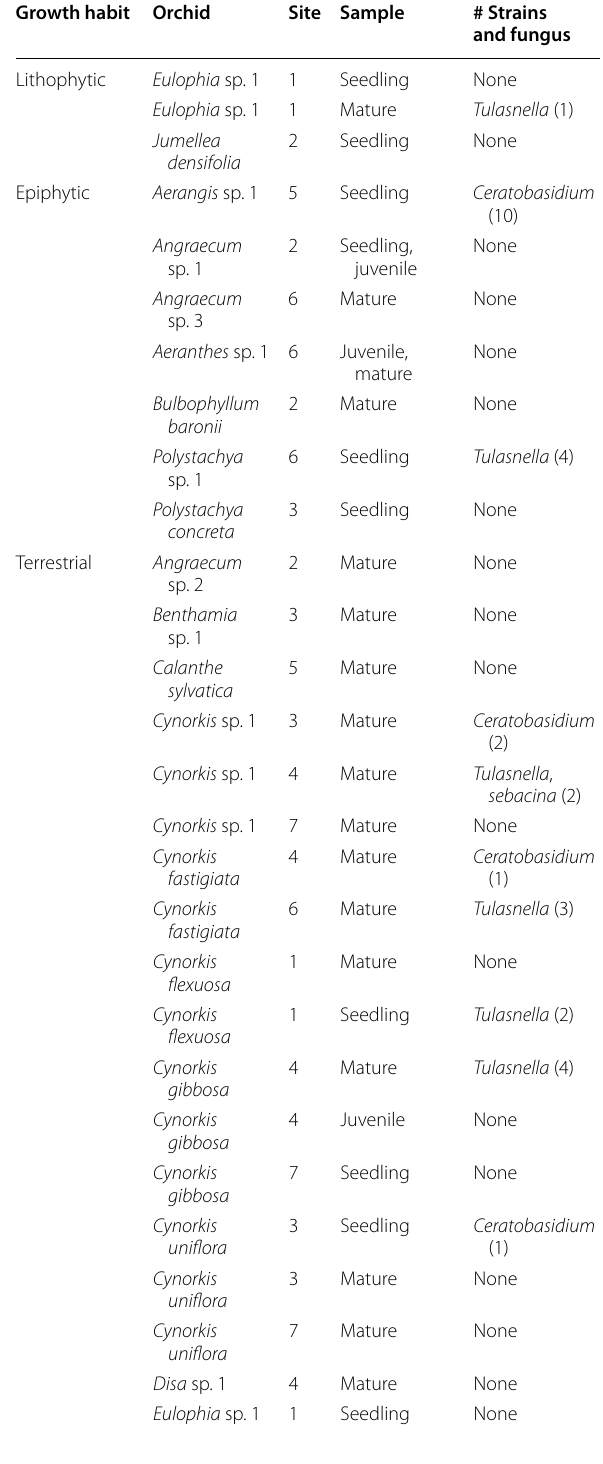
Table 3 A summary of the frequency of Rhizoctonia -like fungi acquired from roots of orchids inhabiting the Itremo Massif of the Central Highlands of Madagascar during Jan- uary 2015 (rainy season) Growth habit